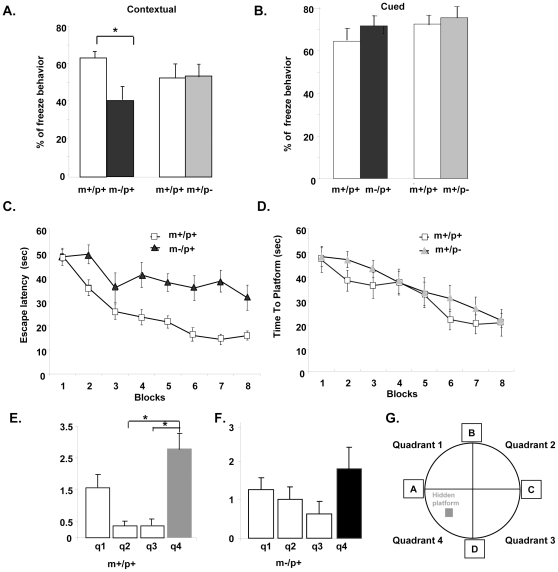
Impaired learning and memory task in mice with a maternal deletion from Ube3a to Gabrb3 (m−/p+).A & B. Fear conditioning. The m−/p+ but not m+/p− mice showed significantly less freezing behavior in contextual fear conditioning (A) but not for cued fear conditioning. C to G. Morris water maze task. The m−/p+ but not m+/p− mice showed significantly longer escape latency than m+/p+ littermates (p<0.001 for m−/p+ and p>0.05 for m+/p−). In the probe trial, analysis of platform crossing found that m+/p+ mice displayed a significantly biased searching strategy, shown in E (p<0.001), while m−/p+ mice displayed a random searching strategy, shown in F (p>0.05). Post hoc analysis of m+/p+ mice revealed that the difference was significant only between quadrant 4 and 2 (p<0.01), and quadrant 4 and 3 (p<0.02). The labeling of each quadrant and location of the hidden platform is illustrated in G. * p<0.05.